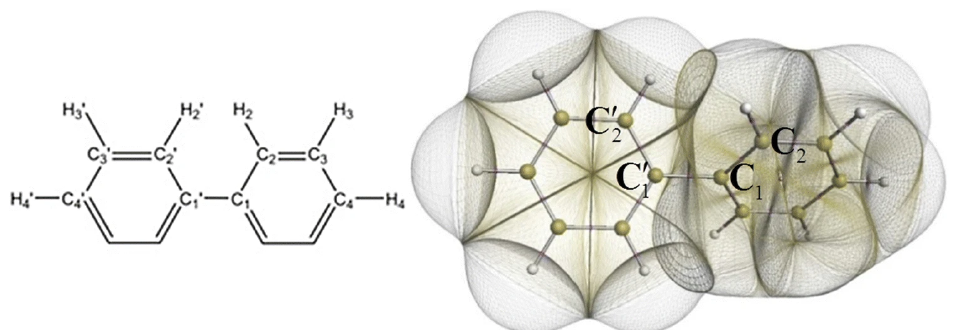
Figure 2. Biphenyl representations. Schematic ( left ) and non-overlapping topological atoms bounded by interatomic surfaces ( right ). Figure from reference